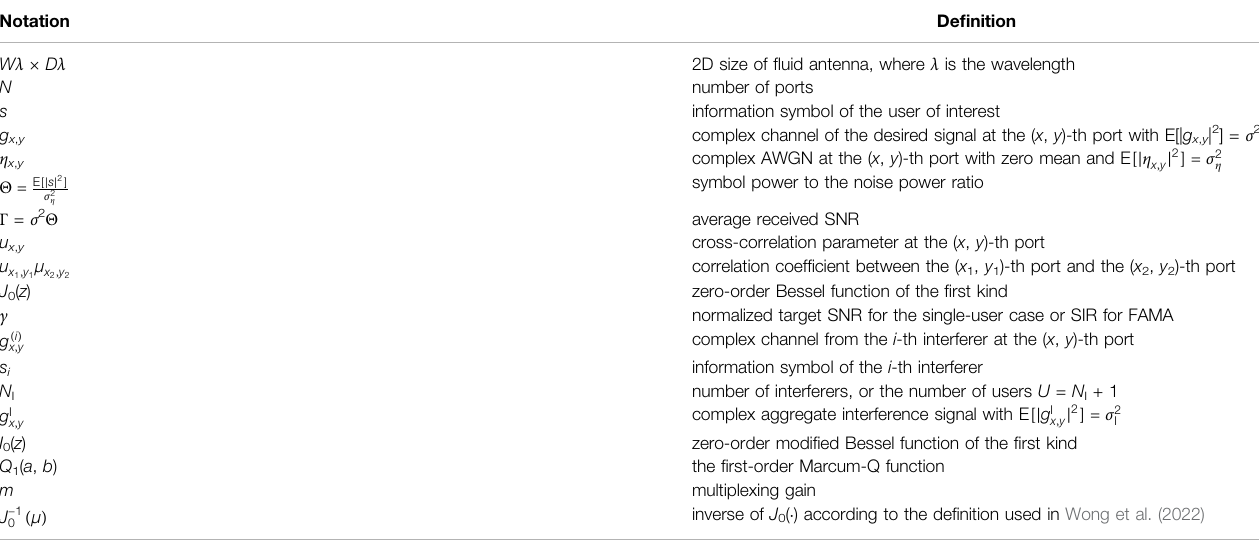
TABLE 1 | Notations of important variables and